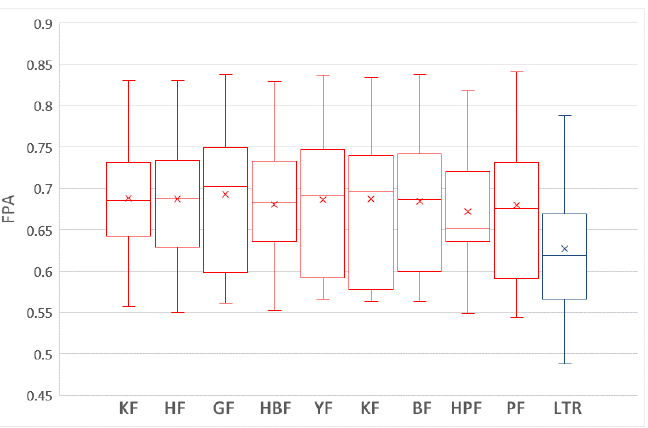
Figure 7. The boxplots of nine training data selection methods and LTR trained on 10% WP data with the Scott–Knott test results in terms of FPA.